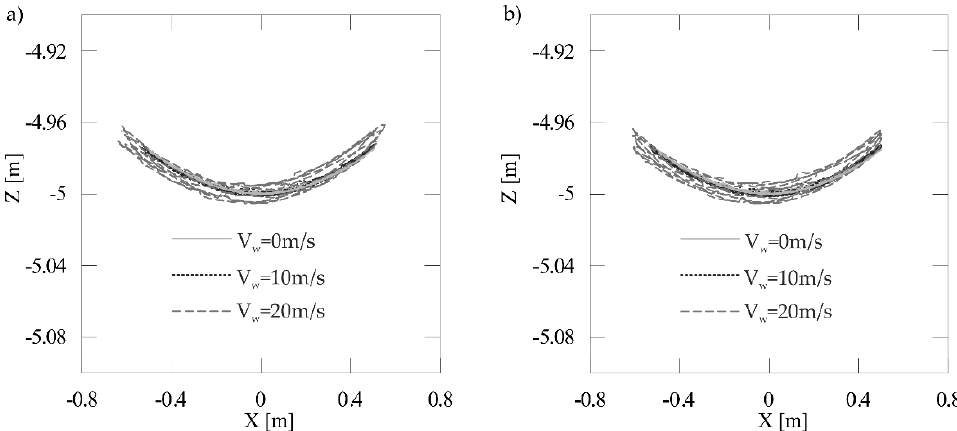
Figure 4. Projection of the trajectory of the carried load’s suspension point on one of the lifting planes for ( a ) the variable effective area and ( b ) fixed effective area.